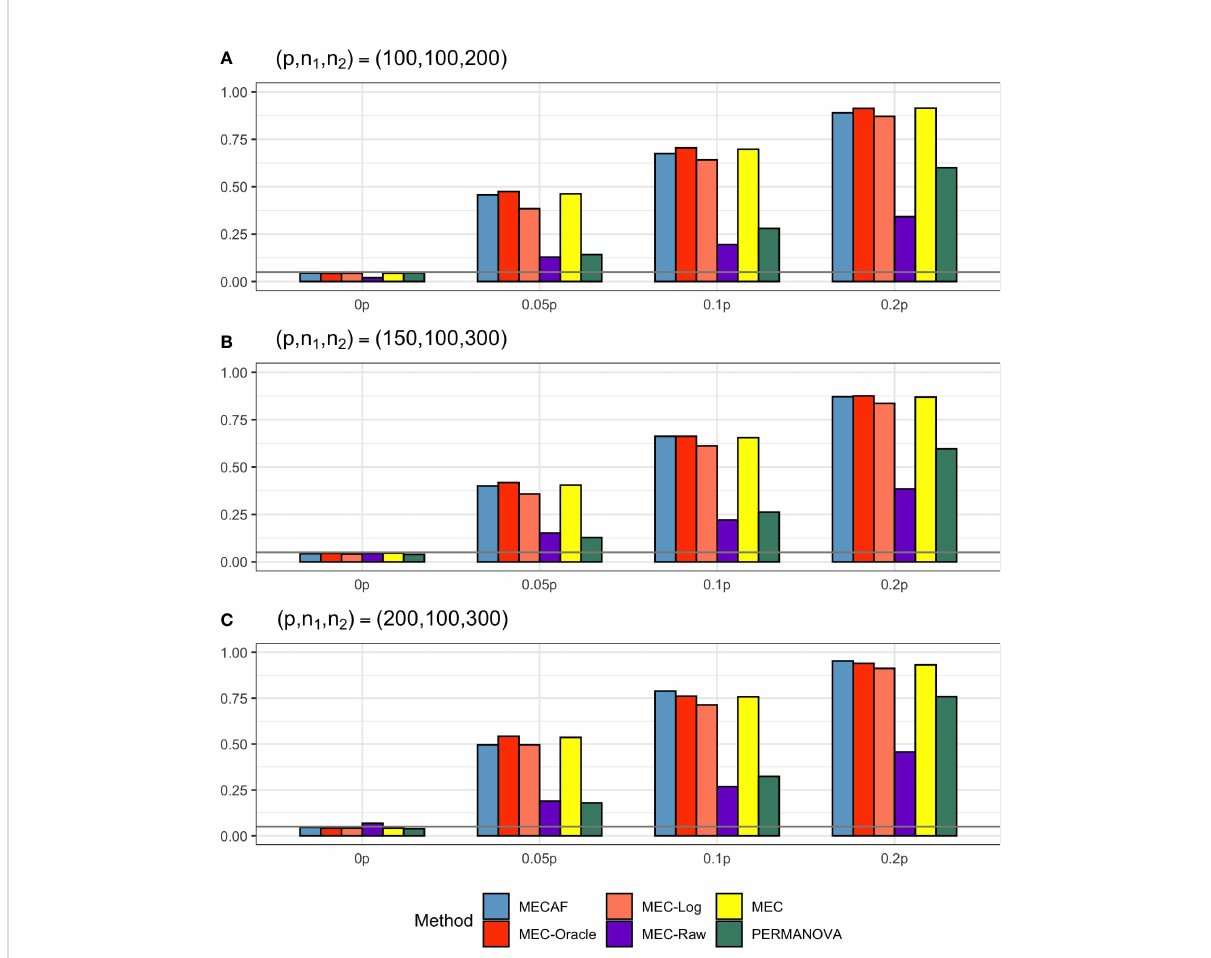
FIGURE 2 Simulation results for Scenario 2: same banded covariance matrix between compared groups. The empirical type I error rate (H_0: 0p) and statistical power under three sparsity measures ( H a :0.05 p , 0.1 p , and 0.2 p ) for MECAF and competing methods MEC-Oracle, MEC-Log, MEC- Raw, and MEC. A horizontal line with a = 0.05 indicates the signi fi cance level. The number of taxa and sample sizes were set as follows: (A) ( p , n p , n n p , n n n 1 , 2 ) = (100,100,200); (B) ( 1 , 2 ) = (150,100,300); (C) ( 1 , 2 ) =